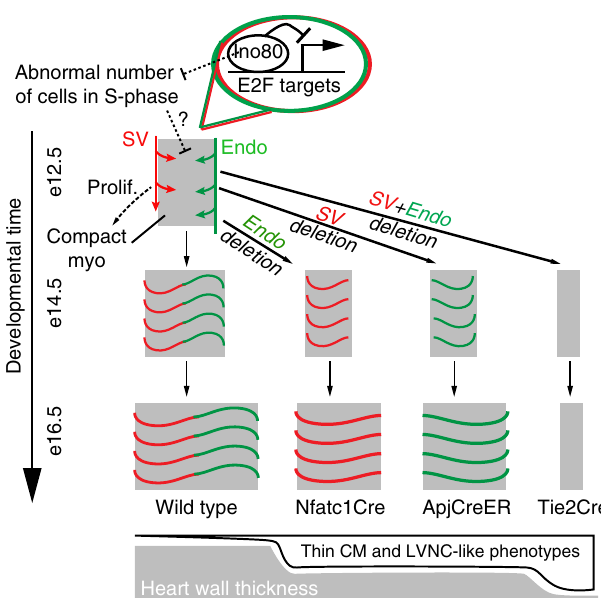
Fig. 8 Model for the role of Ino80 and regional coronary vascularization during heart wall growth. Two major progenitors of coronary vessels exist, the sinus venosus (SV, red) and endocardial cells (endo, green). These progenitors grow into the ventricle walls from different sides of the heart and connect to form the coronary vascular bed, which is coincident with expansion of the compact myocardium. Deletion of Ino80 from each progenitor pool separately, or together using cell type speci fi c Cre lines, results in either medium or severe heart wall thinning/ventricular non- compaction, respectively. Ino80 occupies E2F target gene promoters and suppresses their expression, limiting cells in S-phase and allowing proper angiogenesis. These models highlight that increasing the amount of vasculature through access to multiple progenitor sources